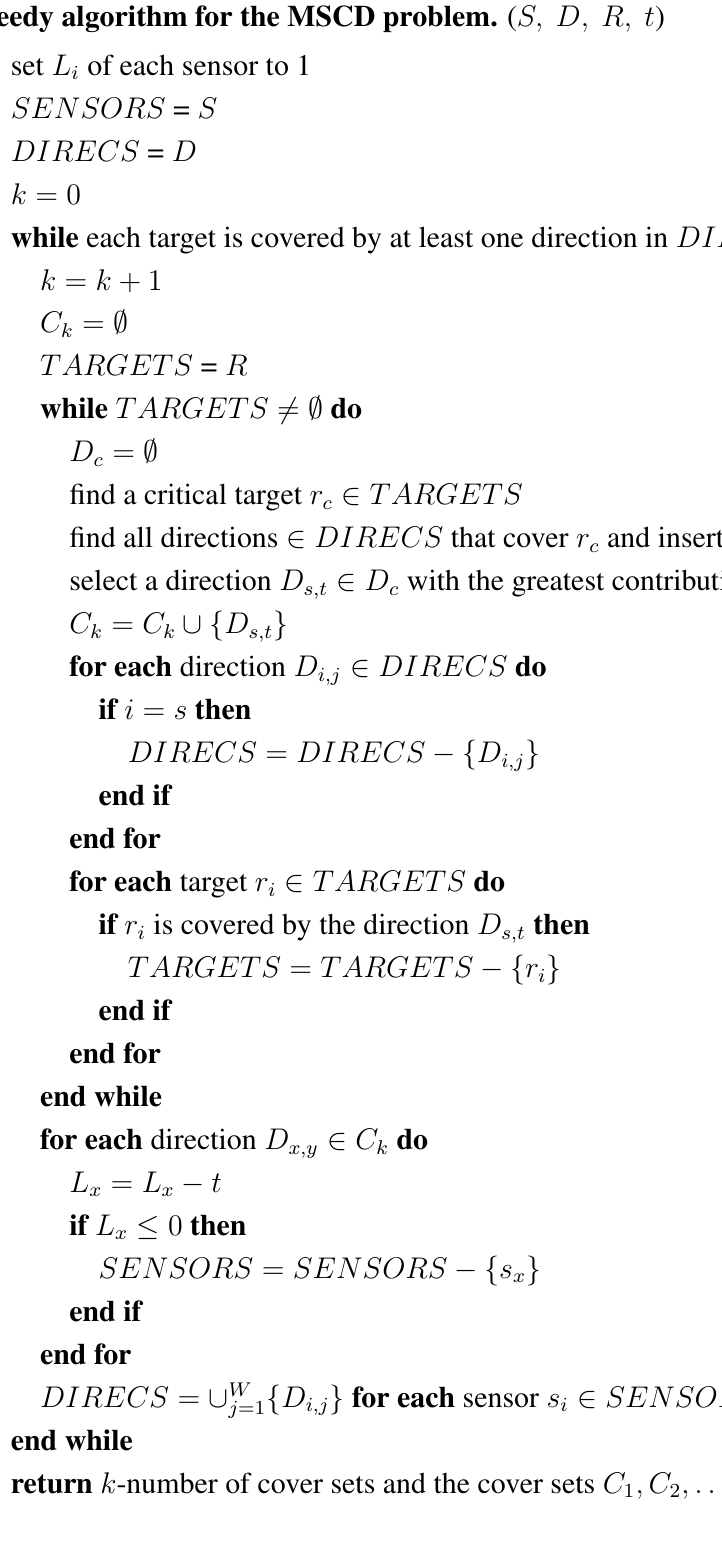
Figure 2. The greedy algorithm to solve the MSCD